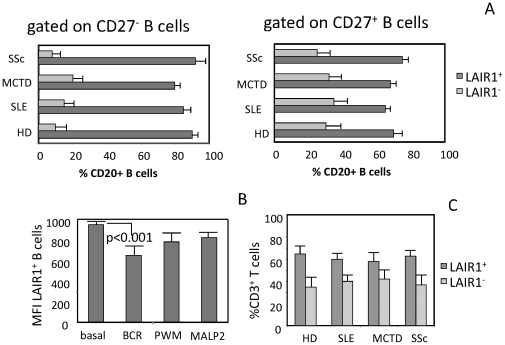
Expression of LAIR1 on naïve and memory B cells, effect of B cell activation on LAIR1 expression and LAIR-1 expression on T cells.Panel A. Percentage of LAIR1+ (black bar) or LAIR1− B (grey bar) cells in naïve (CD27−) or memory (CD27+) cell subsets. Results are determined by triple immunofluorescence assay using specific mAbs to CD20, LAIR1 and CD27 followed by isotype specific GAM conjugated with Alexafluor674 (CD20) or PE (LAIR1) or Alexafluor488 (CD27) on HD or SLE or MCTD or SSc patients. Panel B. Effect of B cell activation on LAIR1 expression. Highly purified healthy B cells were stimulated with sIgM or PWM or MALP2, as indicated, and expression of LAIR1 and CD20 was analyzed as in A. Results are representative of seven independent experiments. Panel C. Expression of LAIR1 on T cells from healthy donors (HD), SLE, MCTD and SSc patients. PBMC were stained with anti-CD3 (JT3A, IgG2a) and anti-LAIR1 (IgG1) mAb followed by anti-isotype specific GAM conjugated with Alexafluor647 or PE respectively. Results are expressed as percentages of CD3+ LAIR1+ (dark grey bar) or CD3+LAIR1− (light grey bar) T cells.